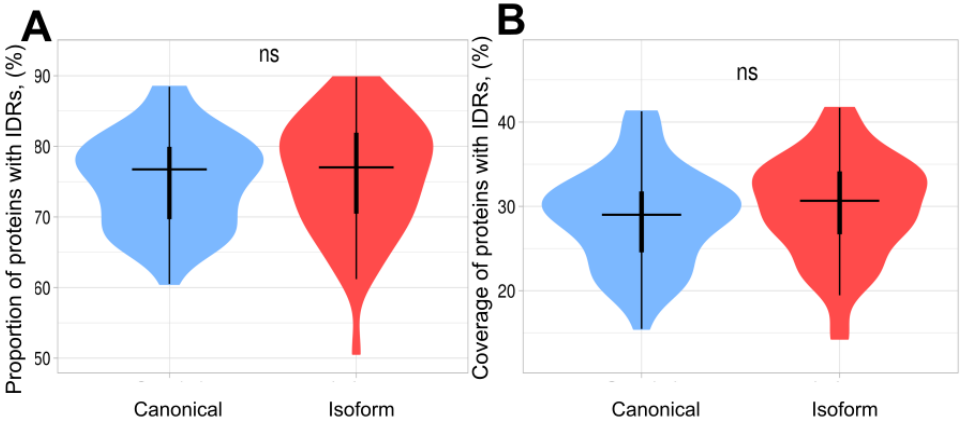
Figure 2. Violin plots of proportion and coverage of proteins containing IDRs in canonical and isoform proteins. The distributions contain 58 points corresponding to each proteome. ( A ) Proportion of proteins with IDRs in canonical proteins and isoforms. The difference between 2 sets is non-significant. ( B ) Coverage of IDRs in canonical proteins and isoforms. The coverage in isoforms is slightly higher; however, this difference is non-significant.